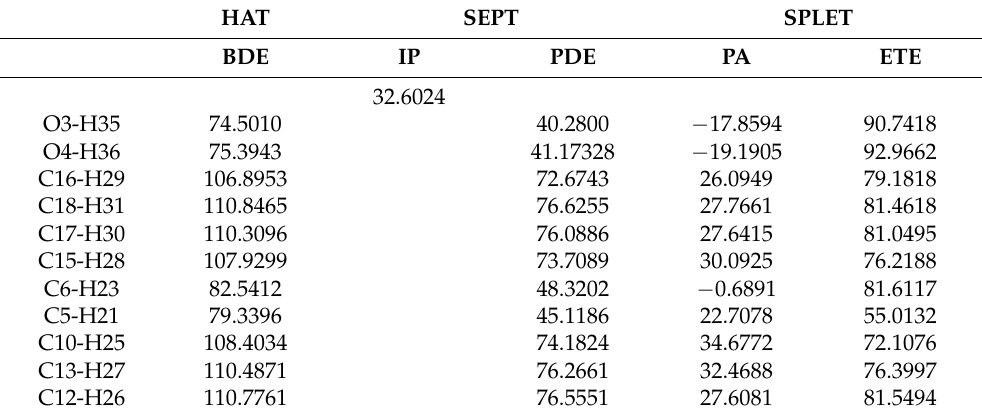
Table 4. The calculated parameters of free radical scavenging activity for LC (in kcal/mol) in water. HAT